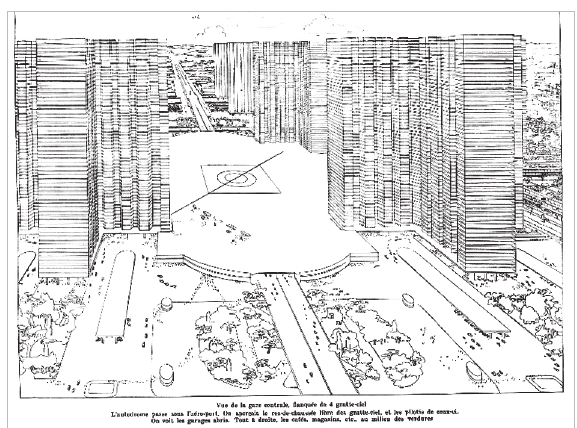
fig. 4. Plan Voisin perspective, vue de la gare centrale “view of Central station, flanked by 4 skyscrapers” (le Corbusier